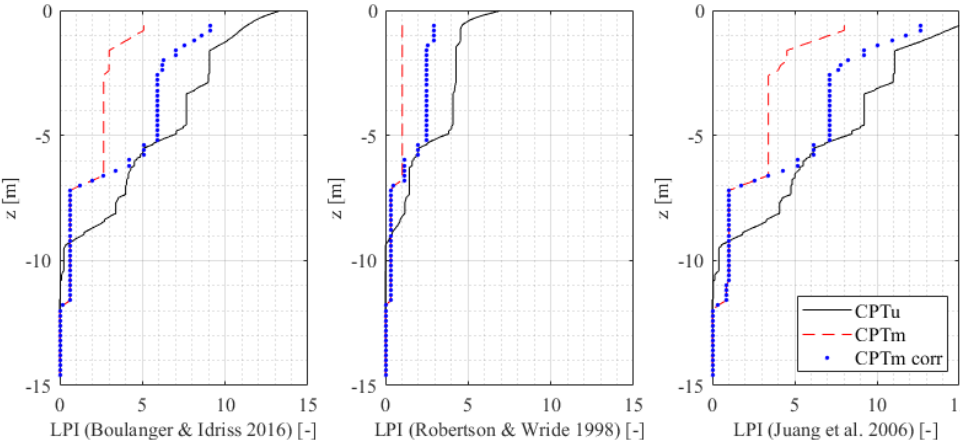
Figure 14. LPI(z) profiles obtained by using the three LEPs considered (CPTu 13, CPTm 6, and CPTm 6 corrected).